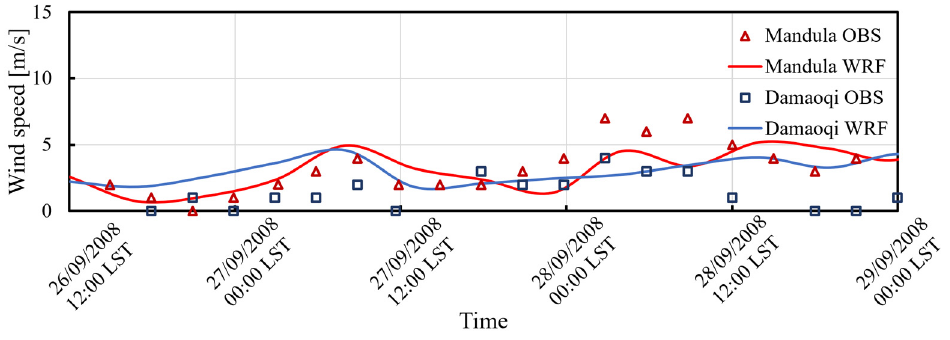
Figure 11. Variation of near-surface wind speed above the main landing area from WRF and weather stations from 12:00 LST on 26 September 2008 to 00:00 LST on 29 September 2008.